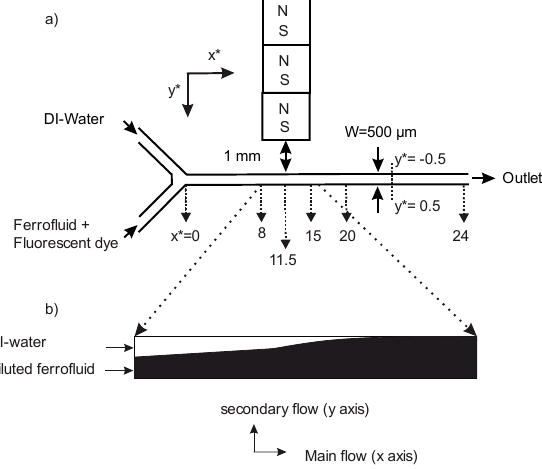
Figure 1. Schematic of the experiment ( a ) Experimental setup ( x * = x / W , y * = y / W ). ( b ) Deflection of superparamagnetic ferrofluid stream towards the magnets due to magnetoconvection, based on experimental observation.